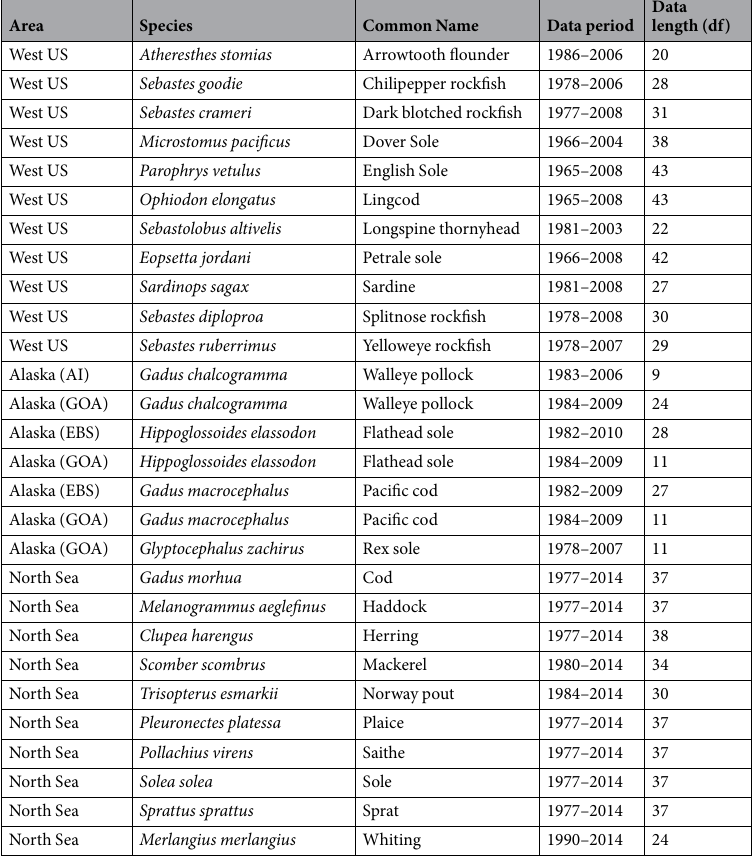
Table 1. Data regions and periods for the 28 commercial stocks. The abbreviation in the bracket indicates the location of stock: AI, Aleutian Islands; EBS, East Bering Sea; GOA, Gulf of Alaska.